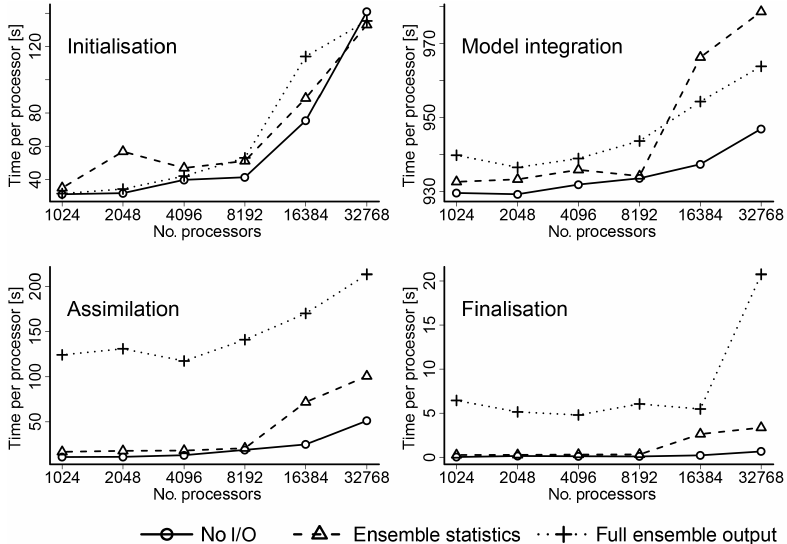
Figure 8. Timing information for individual components of TerrSysMP–PDAF for three I/O scenarios for the ideal test case.